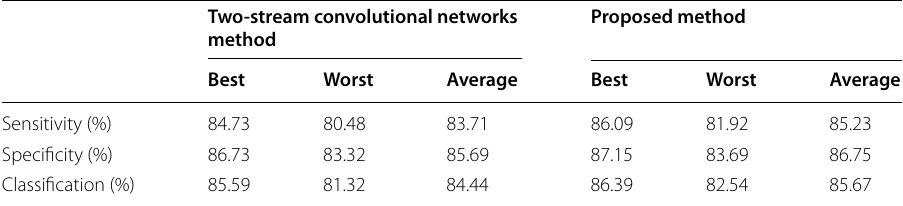
Table 2 Comparison of the proposed method with Two-stream Convolutional Networks